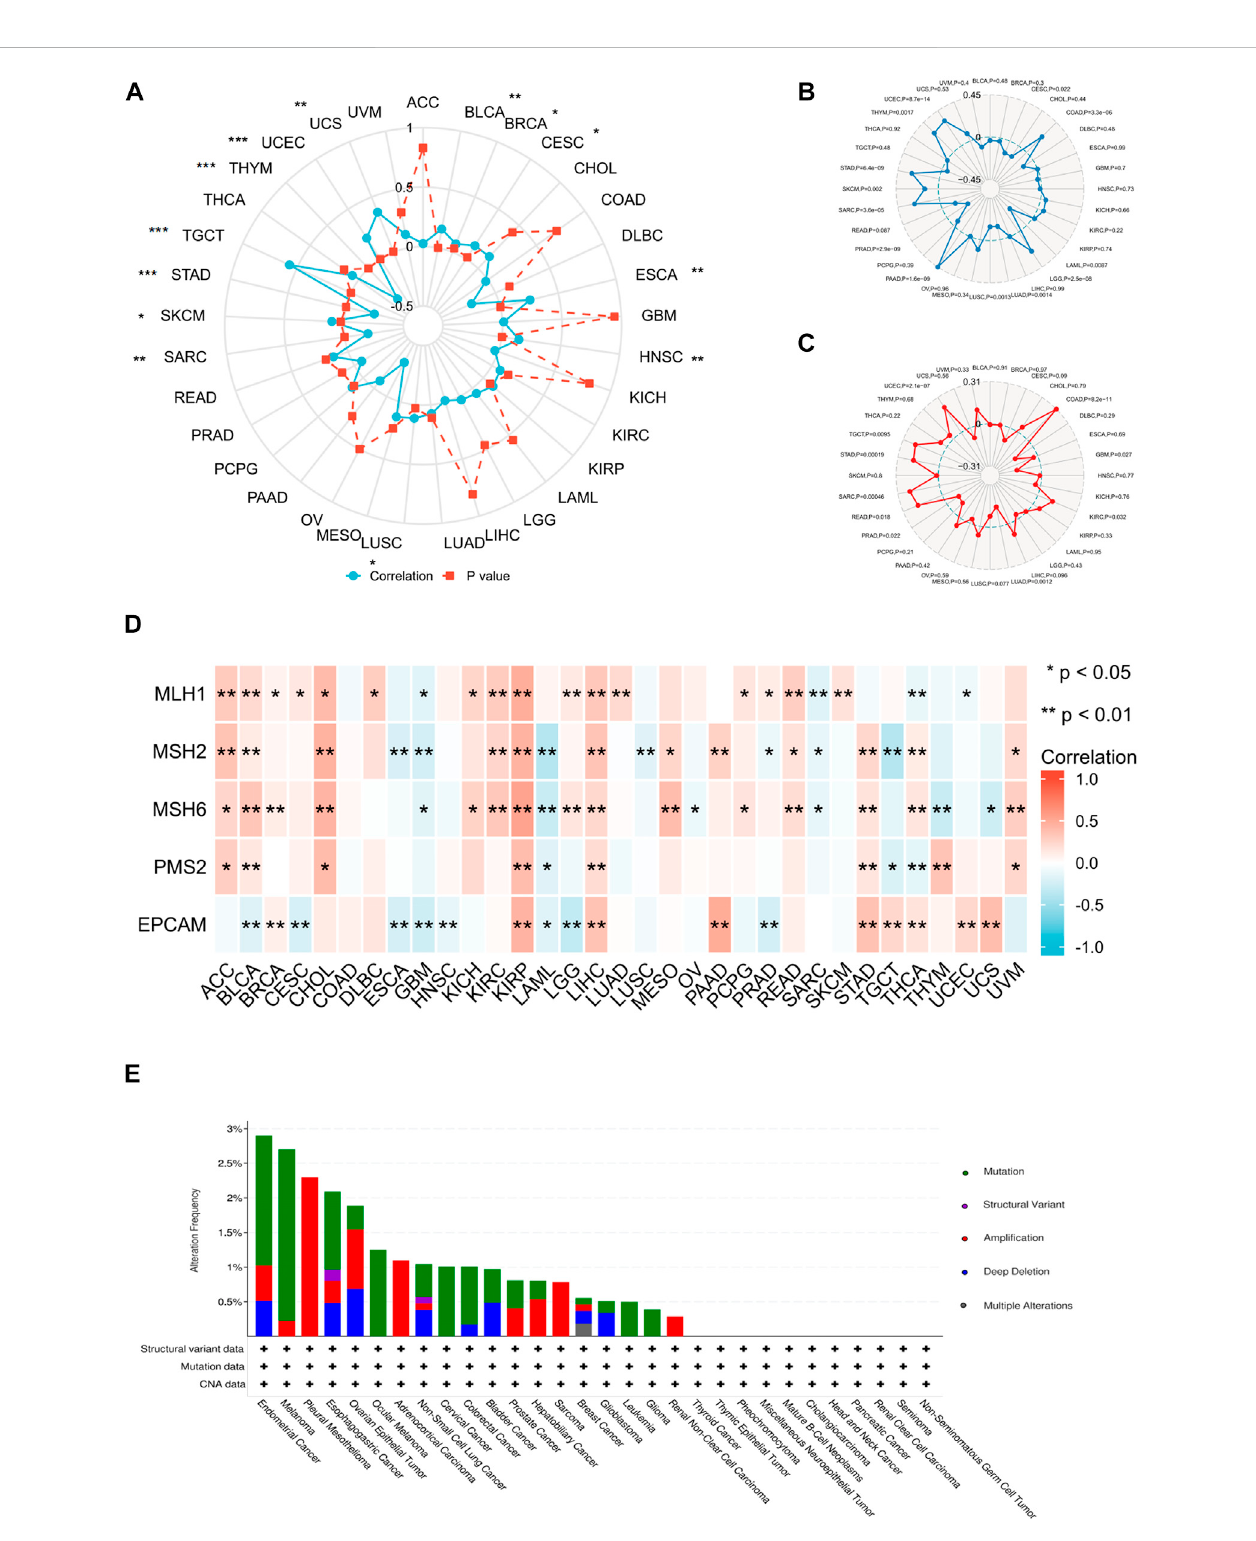
FIGURE 8 Relationship between ANXA2 gene expression and DNA methylation and genetic alteration in pan-cancer. (A) DNA methylation, (B) TMB, (C) MSI, (D) MMR, (E) Genetic variations. * p < .05, ** p < .01 and *** p < .001.